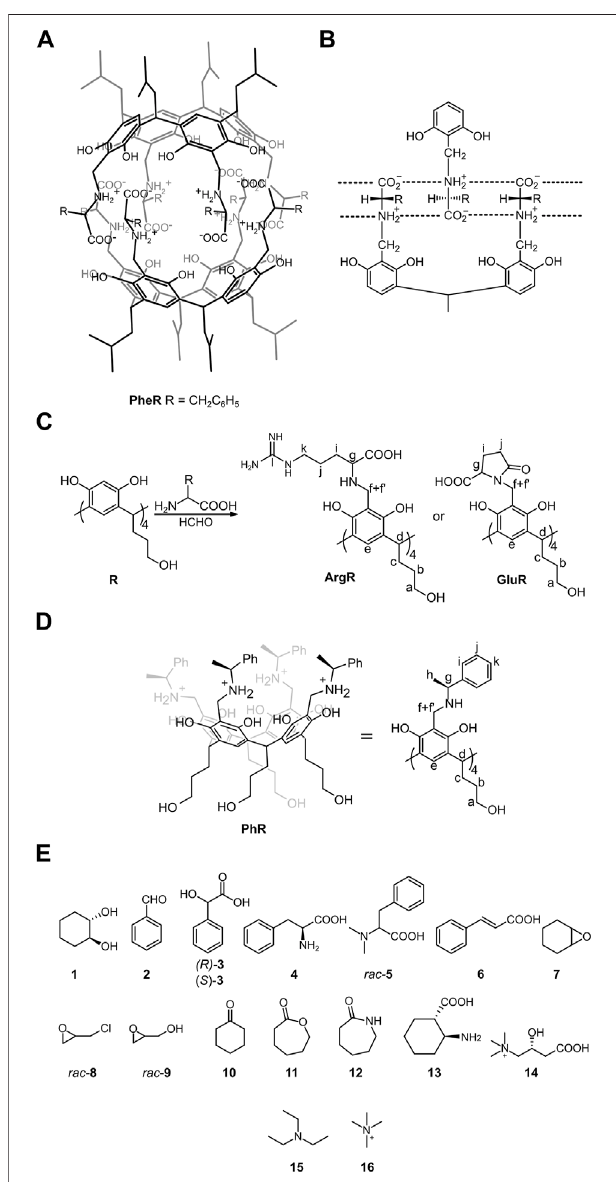
FIGURE 1 | Structures of the compounds used in this study along with notation of the NMR signals: (A,B) hydrophobic capsule (L- PheR ) 2 and its bindingmotif(ref.KuberskiandSzumna,2009); (C) synthesisofwater-soluble cavitands; (D) structure of reference cavitand PhR (ref. Setner and Szumna, 2019); and (E) guest